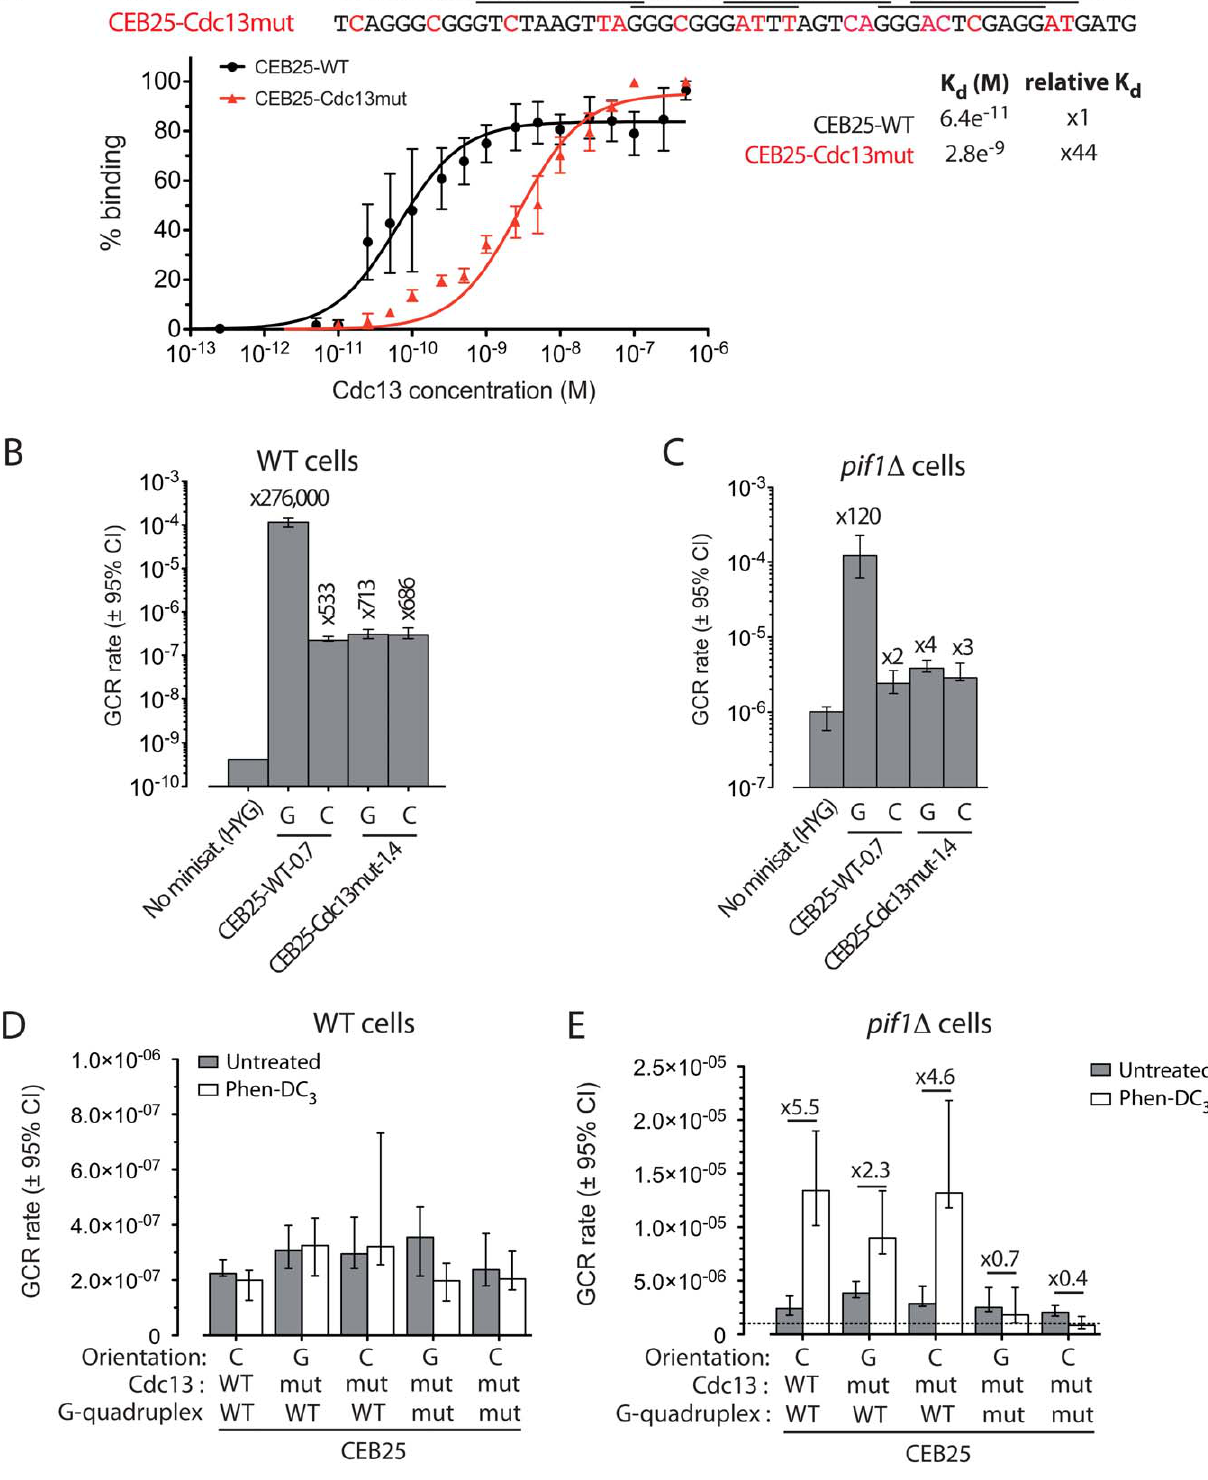
Figure 5. The high rate of GCR induced by CEB25 in an orientation-dependent manner relies on its high affinity Cdc13-binding sites. (A) Analyses of the Cdc13 affinity for CEB25 motifs. The sequences of the CEB25-WT and CEB25-Cdc13mut oligonucleotides used for the gel shift assay experiment are shown. The 11 nt high affinity Cdc13-binding sites (GTGTGGGTGTG, in which the 4 first nucleotides are critical) are underlined [42]. Mutations of the Cdc13-binding sites in CEB25-Cdc13mut are shown in red (16 mutations). The quantification of the proportion of the Cdc13-bound oligonucleotides of CEB25-WT (black) and CEB25-Cdc13mut (red) as a function of the Cdc13 concentration is shown. A second order binomial fit has been applied. Absolute K d values 6 SD and fold difference compared to the CEB25-WT motif are indicated. (B) GCR rates in the